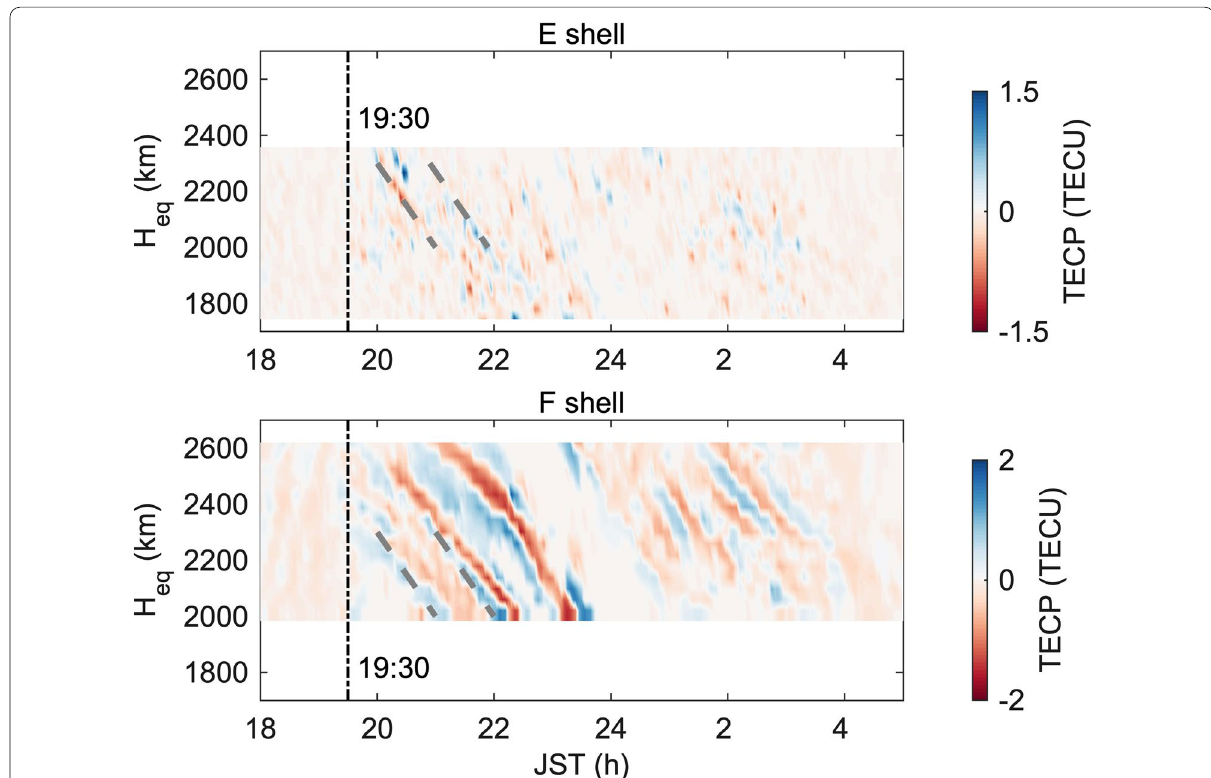
Fig. 8 Time variation of TECPs on 23 June 2012 (DOY 175) along the northeast–southwest red dashed in Fig. 1. H eq is the equatorial crossing height of the magnetic field line piercing each shell. The top and bottom panels represent E- and F-shells, respectively. The black and gray dashed lines represent the occurrence time of perturbations and the alignment of evident downward-sloping stripes, respectively. Evident, particularly between 20:00 ~ 23:59 JST, is the southwestward propagating wavefronts in both E- and